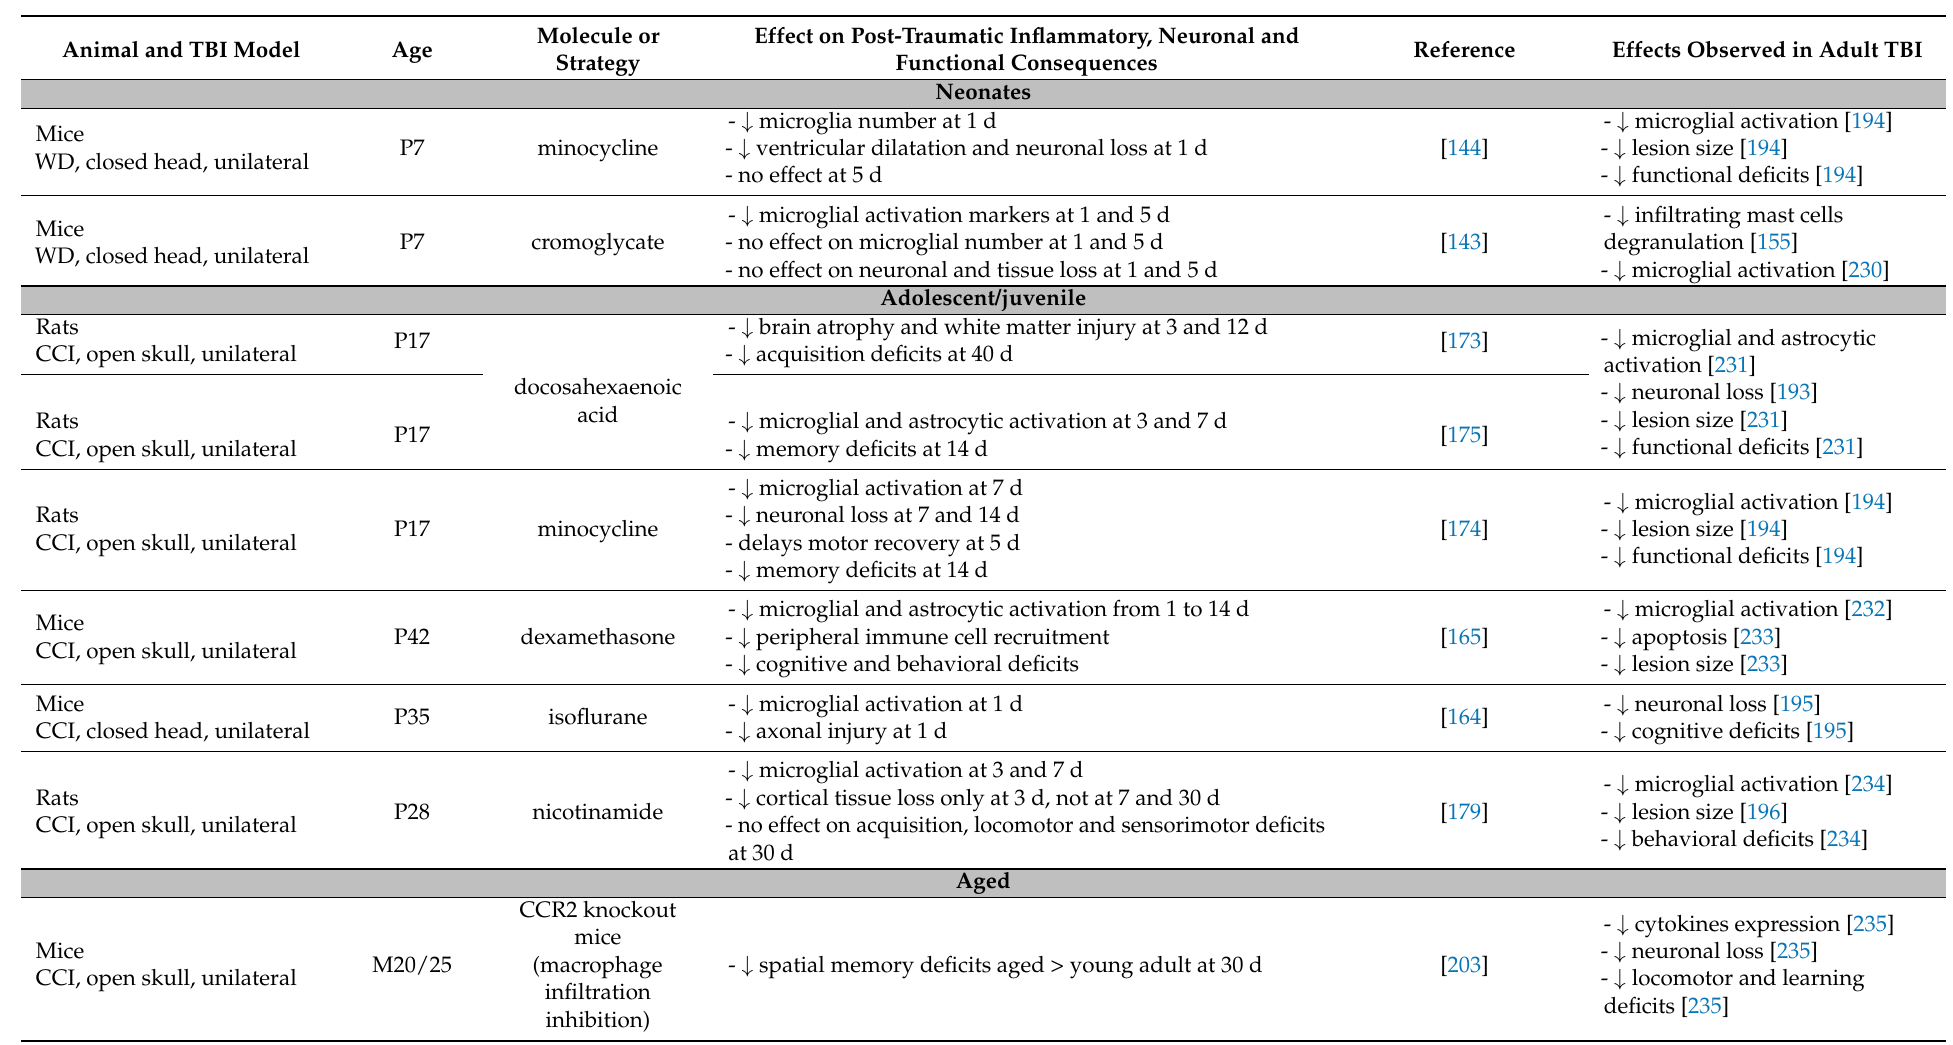
Table 6. Effect of neuroprotective strategies in different age groups. Abbreviations: ↑ : increase; ↓ : decrease; CCI: controlled cortical impact; CCR2: C-C chemokine receptor type 2; d: days post-injury; LFP: lateral fluid percussion; M: post-natal months; P: post-natal days; TBI: traumatic brain injury; WD: weight drop